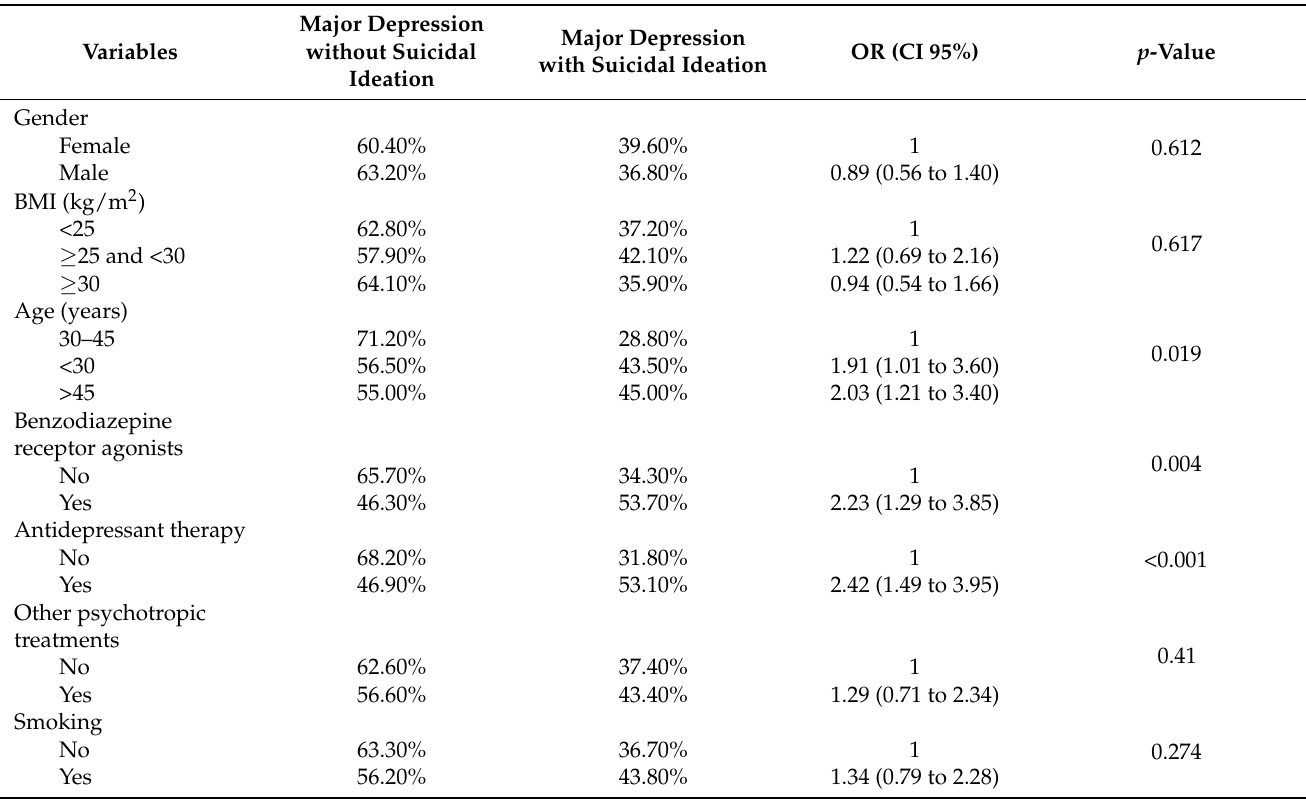
Table 2. Univariate analyses ( n =